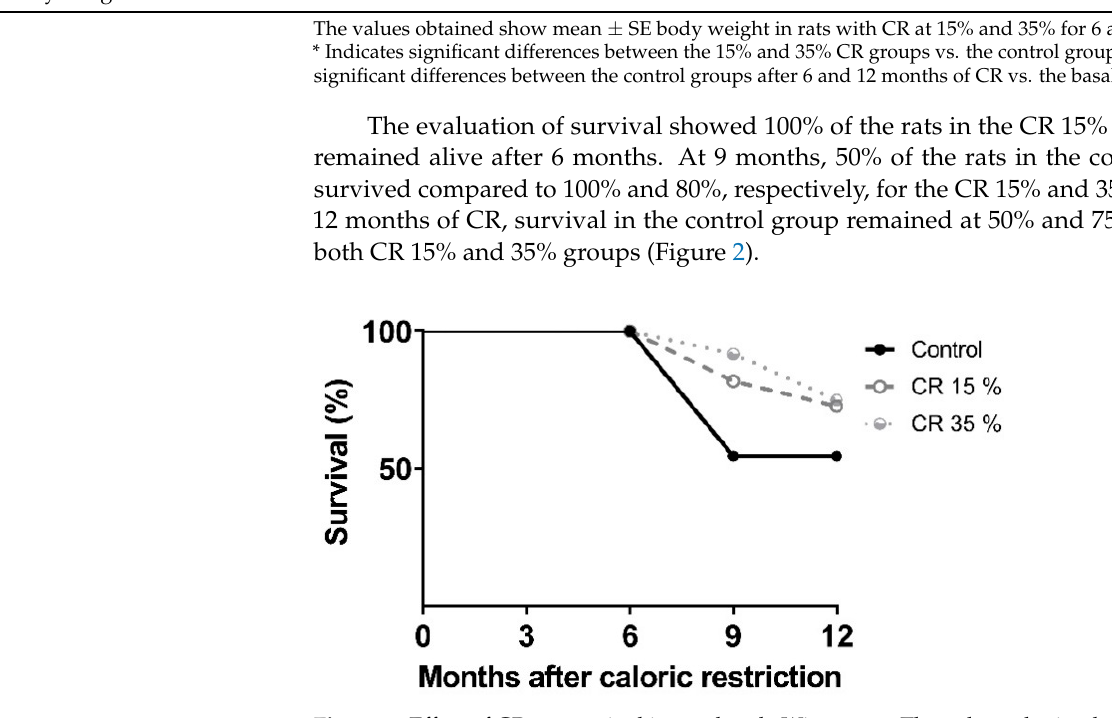
Figure 2. Effect of CR on survival in aged male Wistar rats. The values obtained show percentage of survival of the rats with CR at 15% or 35% for 6 and 12 months of CR.